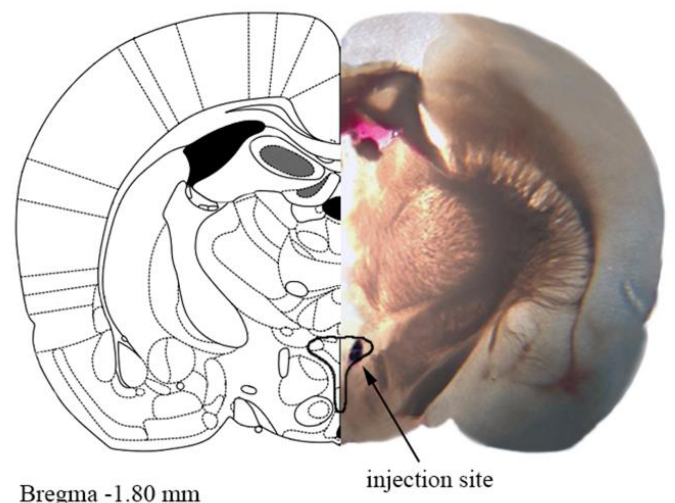
Figure 1. A representative photograph of the microinjection site in the paraventricular nucleus of hypothalamus (PVN) coupled with the matching slide from the Paxinos and Watson rat brain atlas [24]. One mm thick brain slice with the injection site shown by Evans blue dye. The drawn outline represents the confines of PVN.